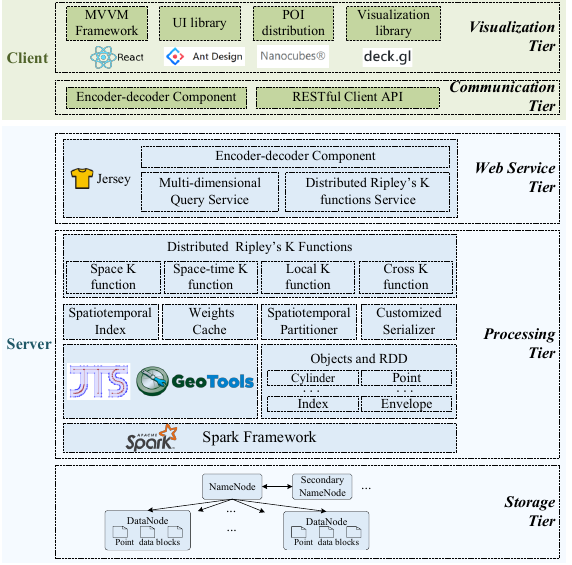
Figure 13. Web-based visual analytics framework for distributed Ripley’s K functions